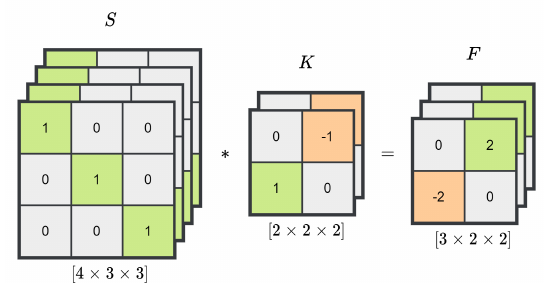
Figure 4. An illustration of 3D convolution. The 3D convolution operation effectively applies the kernel in one additional dimension cmompared to the normal convolution, the depth or z -axis. Like the input, the kernels are three dimensional. The dimensions of the feature map conform to how many times a kernel can wholly be applied to the input data along all three dimensions. With stride of one in each dimension, a [ 2 × 2 × 2 ] kernel is applied on a [ 4 × 3 × 3 ] input sequence of layers two times in x and y dimensions and thrice in z dimension, resulting in a [ 3 × 2 × 2 ] feature map, its values being sums of products over distinct applications of K akin to 2D